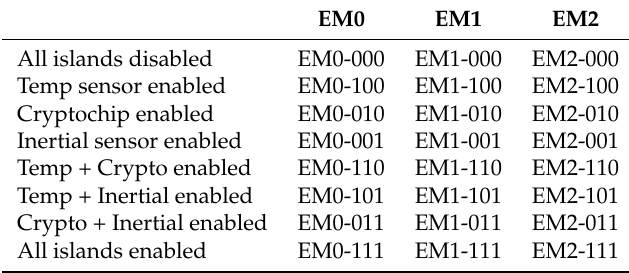
Table 1. Combined low-power modes of the Cookie Edge Node, allowing the creation of a more advanced range of power profiles.